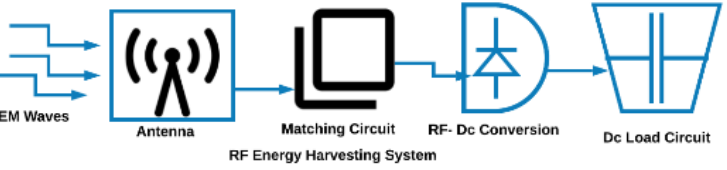
Figure 15. Model of Radio Frequency (RF) Energy